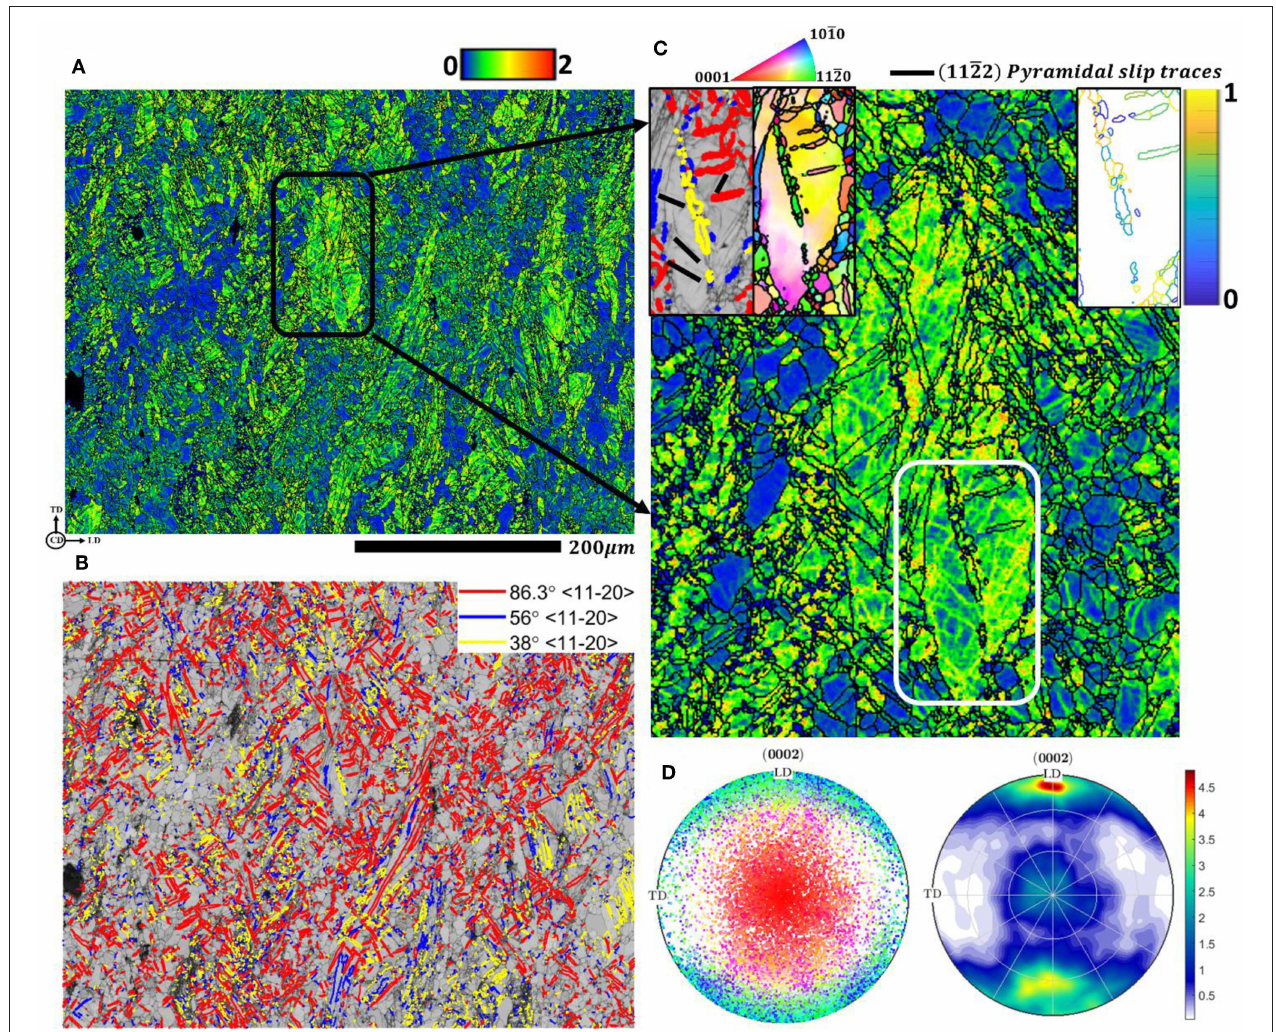
FIGURE 4 | (A) Kernel average misorientation map corresponding to ZEK110 deformed to 6% strain under plane strain compression, (B) corresponding image quality map with twin boundaries as { 1012 } extension twins (highlighted in red), { 1011 } compression twins (blue) as well as { 1011 } − { 1012 } double twins (yellow); (C) magnified image of the area highlighted in this figure. Corresponding inverse pole figure map as inset on the top left corner and the map showing the grain boundaries colored with respect to the degree of transparency to (1122 < 1123 > pyramidal slip transmission. Red lines overlaid on the map confer with (1122) pyramidal slip traces. Grain boundaries larger than 3 ◦ are shown in black. (D) (0002) single orientation scatter data and recalculated pole figures for the EBSD map shown in (A) .